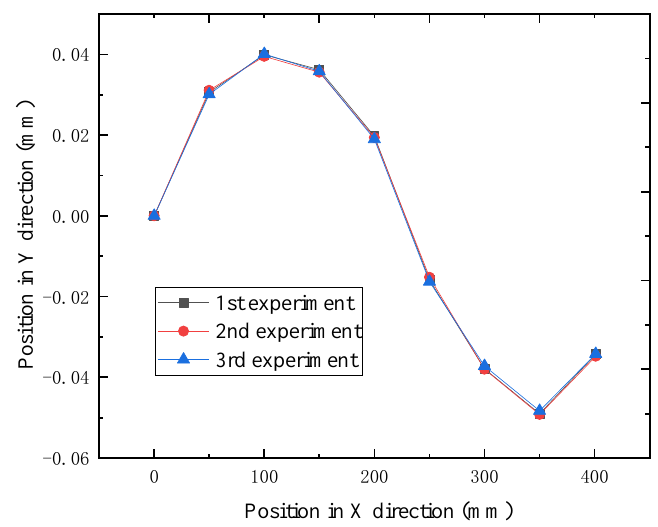
Figure 10. Repeatability of the calibration experiment.